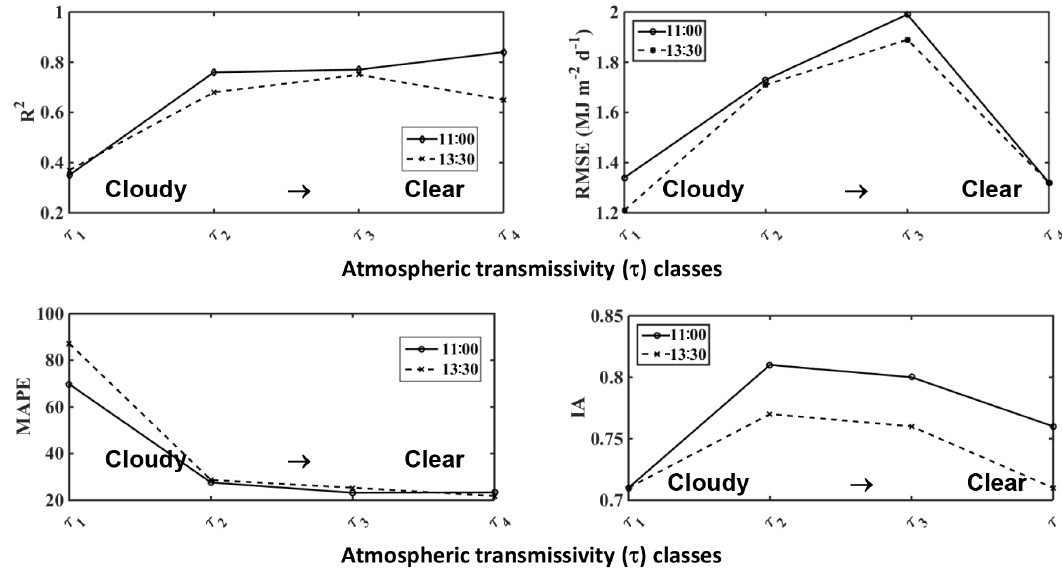
Figure 8. Assessing the statistical metrics of ET d_pred (using Eq. 1) for different levels of daily atmospheric transmissivity classes (repre- senting cloudy to clear skies) for both 11:00 and 13:30LT time-of-day ET i